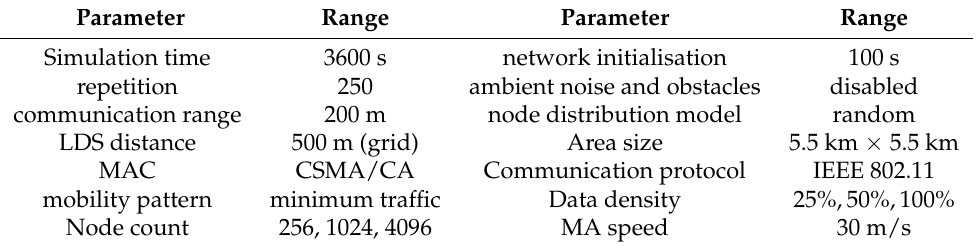
Table 2. Simulation